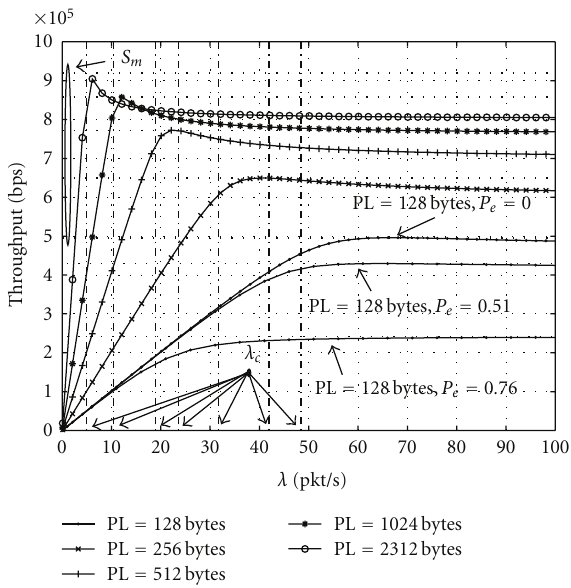
Figure 4: Behavior of the aggregate throughput as a function of λ , Figure 5: Behavior of λ c in (14) as a function of the number of for five di ff erent values of the packet size as noticed in the legend. contending stations, N , for two di ff erent values of both E [PL] and P In each simulated scenario there are N = 10 contending stations e as noticed in the respective legends. Other parameters are as transmitting at 1Mbps. Other parameters are as follows: W 0 = 32, follows: W 0 = 32 and m = m = 5. The values of λ P e = 0, and c are noticed on the abscissa, whereas the horizontal lines, labeled by S m , represent the maximum aggregate throughput (link capacity) evaluated through (13) in each considered scenario. All the thick curves refer to E [PL] = 128 bytes, and various packet error probabilities as noticed in the figure.